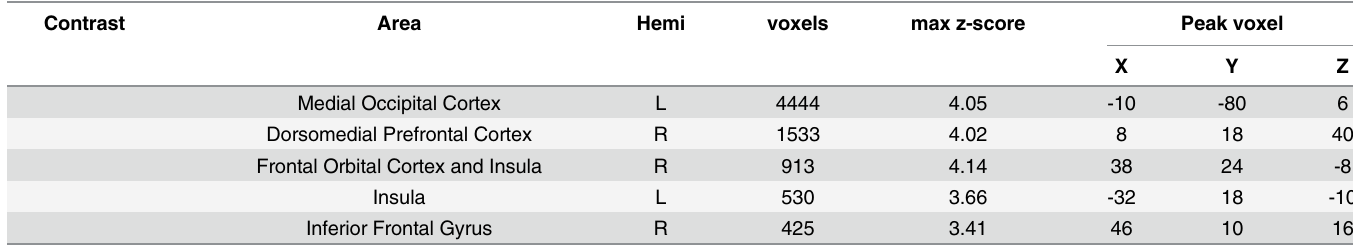
5.7, Right: 62, -10, -26, max z: 5.6), left lateral occipital cortex (-44, -62, 38, max z: 6.2), left frontal orbital cortex (-48, 36, -12, max z: 6.1) and precuneus (-4, -58, 30, max z: 6.54) (Fig